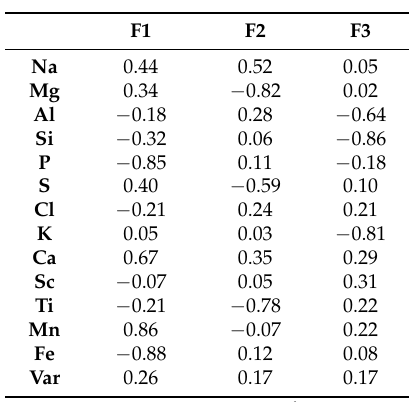
Table 4. Factor loadings of selected element concentrations of ferromanganese colloform matrix. Varimax raw rotation of factors was applied.